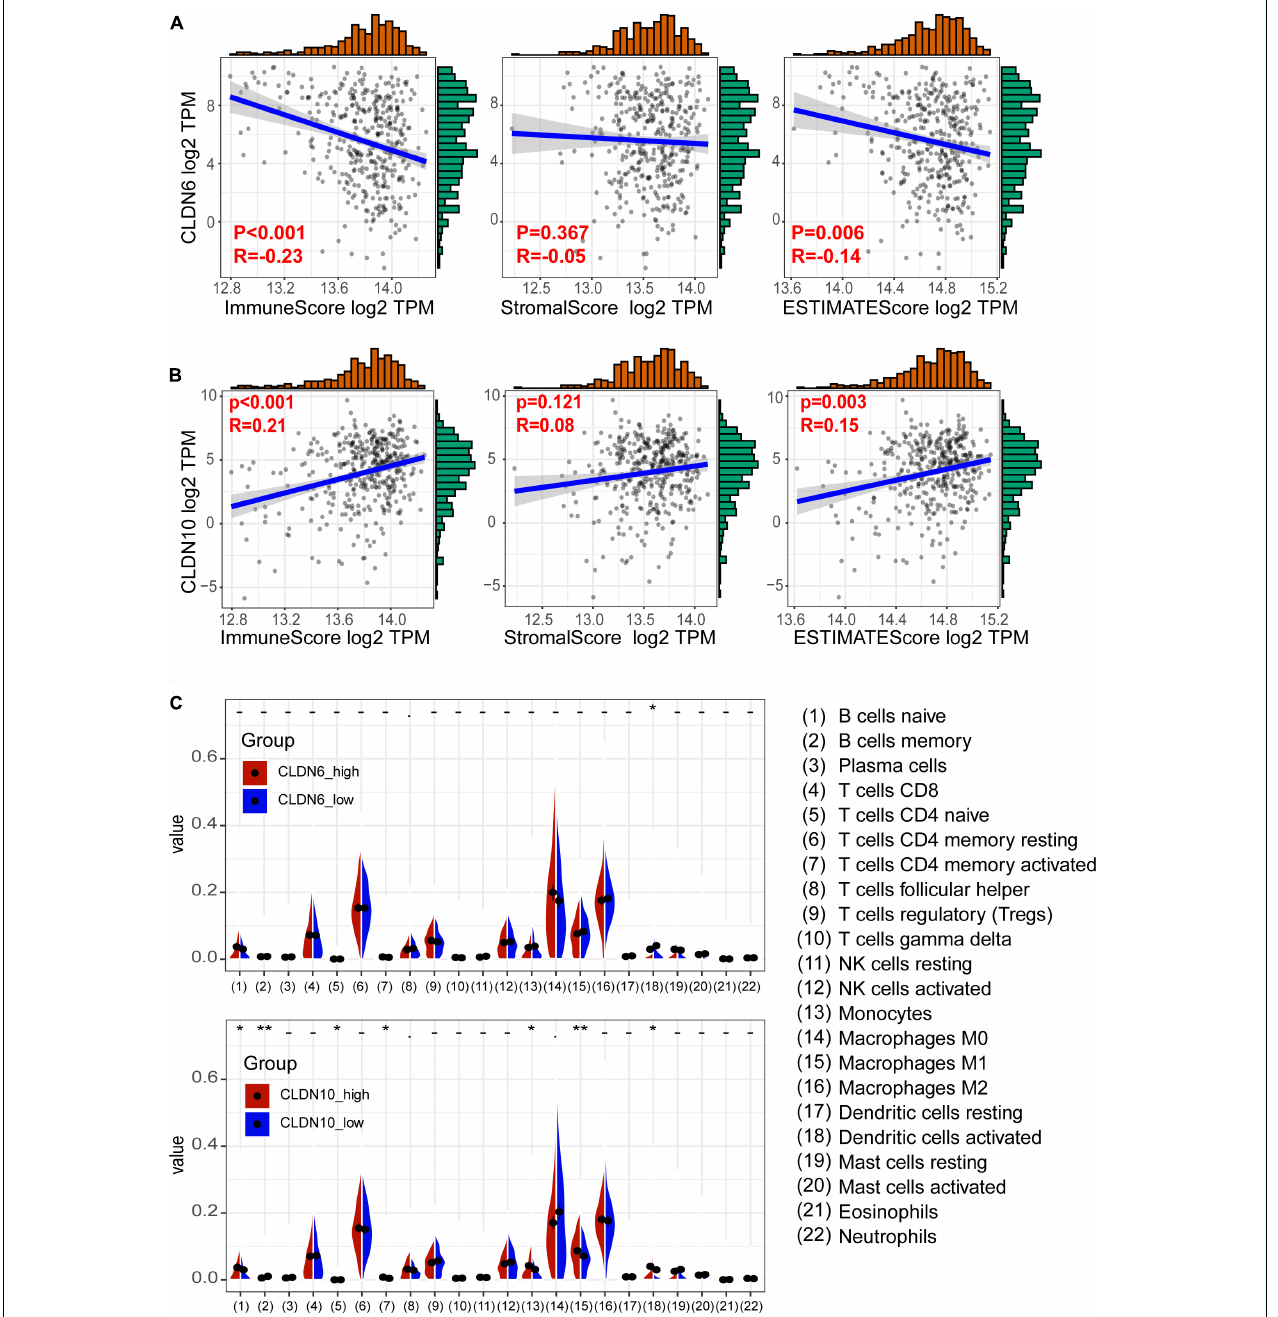
FIGURE 5 | Relationship between claudins expression and tumor immune microenvironment. (A) The expression of CLDN6 has a negative correlation with immune score and ESTIMATE score. (B) The expression of CLDN10 has a positive correlation with immune score and ESTIMATE score. (C) The difference of 22 immune cells between the claudin-high group and claudin-low group (* p < 0.05, ** p <